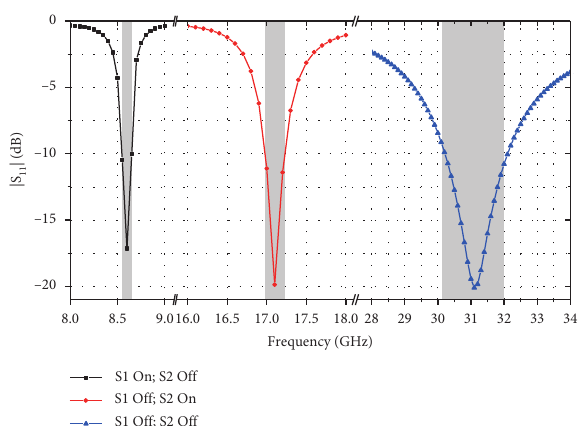
Figure 3: Simulation results of reflection coefficients at different frequency reconstruction states.